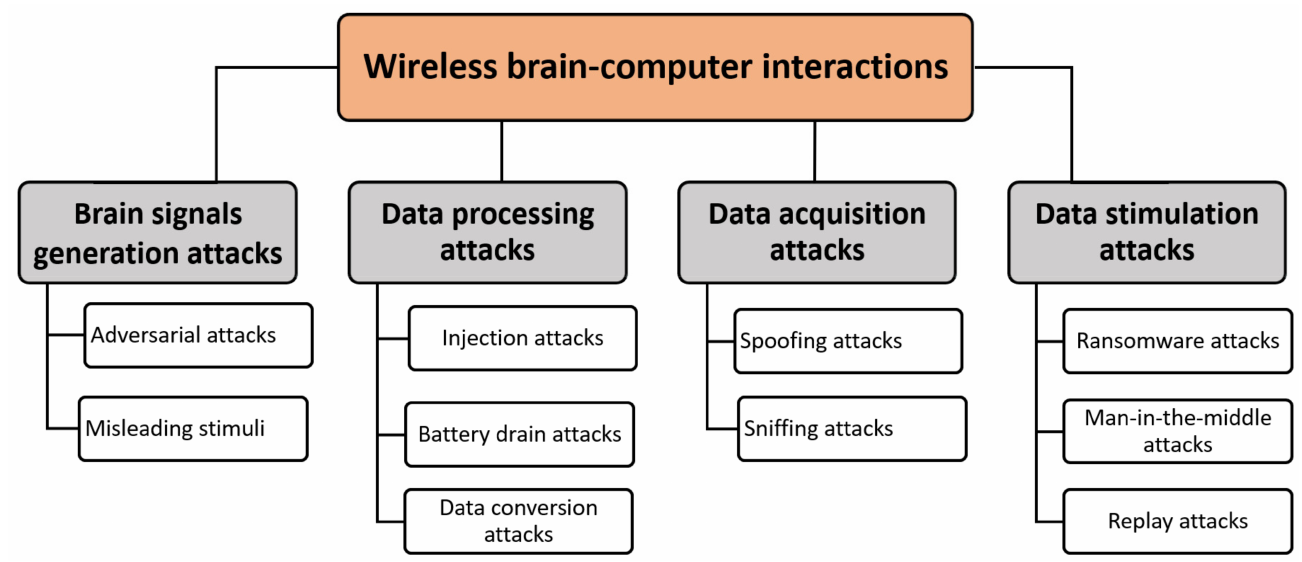
Figure 10. The wireless brain-computer interaction attacks and